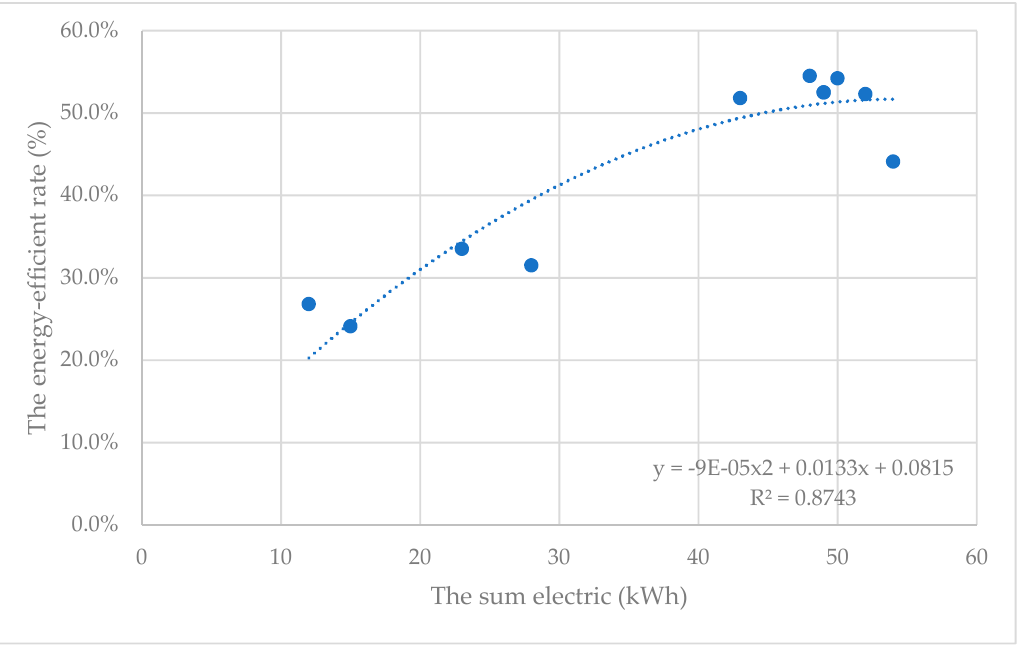
Figure 10. The accumulated energy consumption (kWh) and energy-efficient rate (%) of elevator group from 1 July 2016 to 11 July 2016.